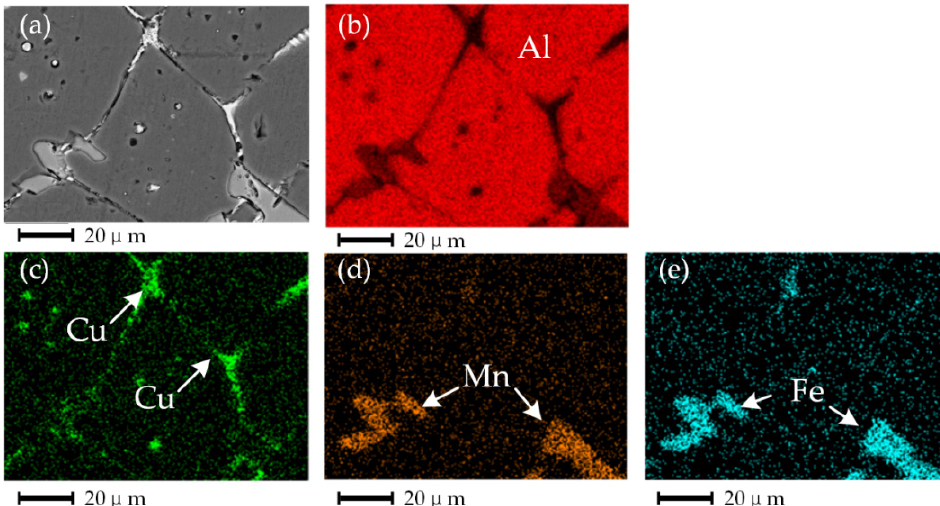
Figure 7. Results of the energy dispersive spectrum analysis, ( a ) microstructure when holding temperature is 620 ◦ C and holding time is 10 min, ( b ) distribution of Al, ( c ) distribution of Cu, ( d ) distribution of Mn, and ( e ) distribution of Fe.